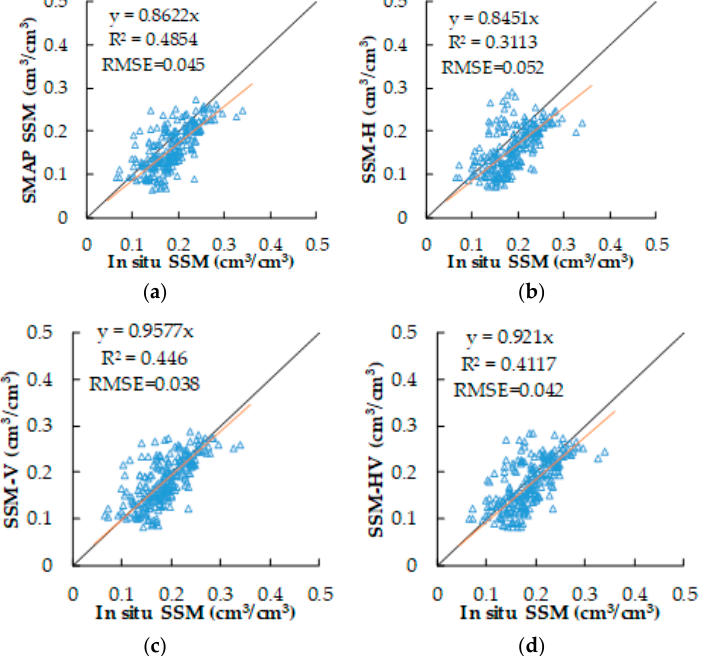
Figure 9. Comparison of in situ SSM values (cm 3 /cm 3 ) and retrieved SSM values (cm 3 /cm 3 ) for ascending orbit from 2016–2018. ( a ) SMAP L3, ( b ) H pol, ( c ) V pol, ( d ) 0.5(H + V). The black line is the 1:1 line and the brown line is the fitted linear equation.